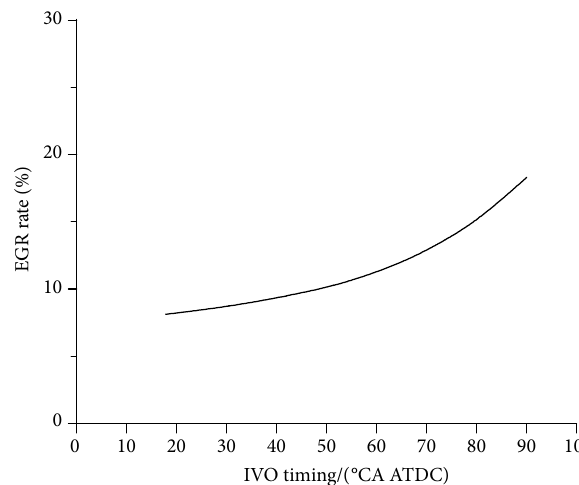
Figure 12: In fl uence of delayed degree of IVO on EGR rate.